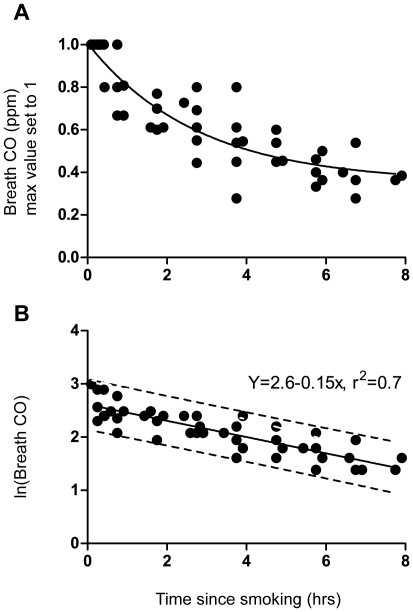
Time course of CObreath decline after smoking one cigarette (group 1).
A. After normalisation against each individual peak value, relative CObreath values were plotted as a function of time since smoking. By non-linear regression, a one phase exponential model was fitted to the decay (Y = (Y0-0.35)*e−0.36×+0.35, r2 = 0.77). B. The natural logarithm of CObreath, ln(CObreath) was plotted versus time since smoking, and the decay was described by linear regression (Y = Y0-0.15×, r2 = 0.70). From the slope, CObreath half-life during the day was estimated to 4.5 hours (ln(2)/slope). The 95% prediction limits are also showed in the figure (dashed lines).